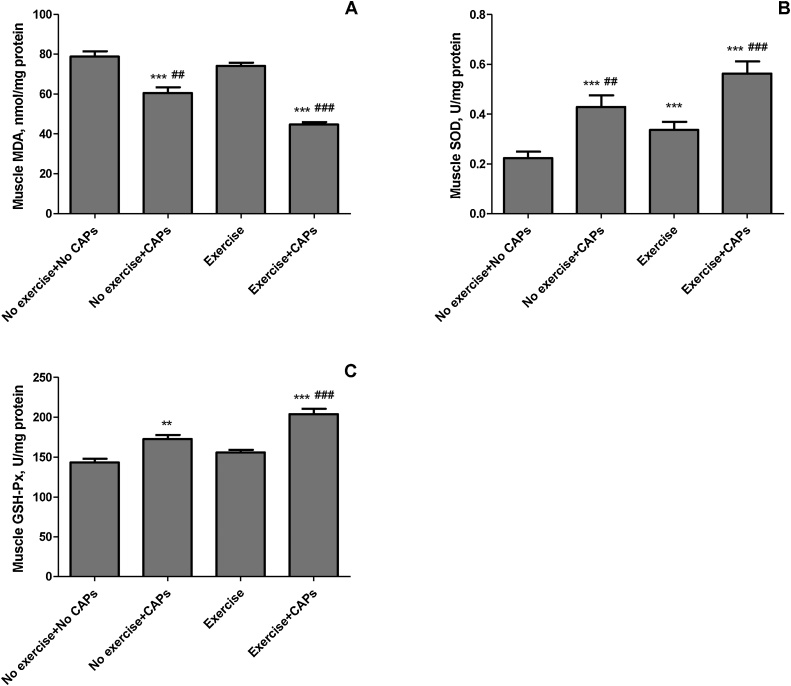
The effects of Capsaicinoids (CAPs) on muscle lipid peroxidation [Panel A: muscle malondialdehyde (MDA)] and antioxidant enzymes [Panel B: muscle three forms of superoxide dismutase (SOD) (mitochondrial, cytoplasmic, and extracellular); Panel C: Glutathione peroxidase (GSH-Px)] in regular exercise-trained rats. Each bar represents the mean (n = 7) and standard error. ** p < 0.01, *** p < 0.001 as compared with control group; ## p < 0.01, ### p < 0.001 as compared with exercise group.